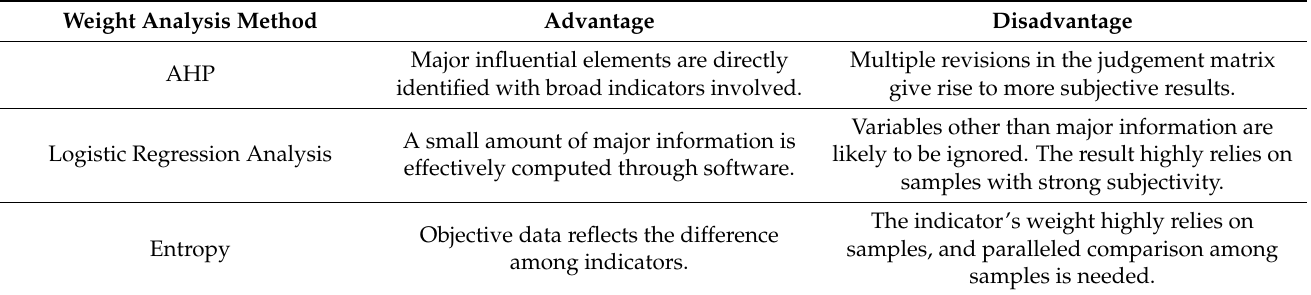
Figure 3. Assessment model of site selection of affordable housing. Table 1. Comparison of weight analysis methods.